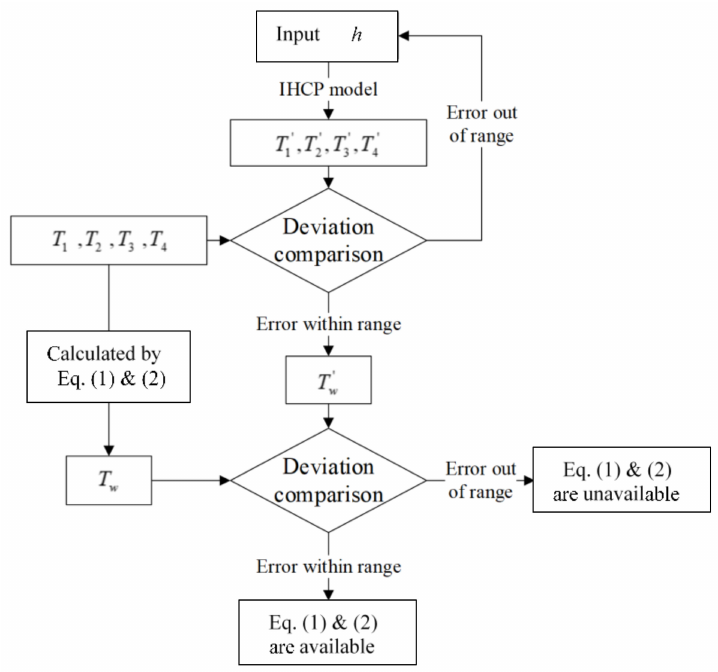
Figure 4. The verification process of two methods.